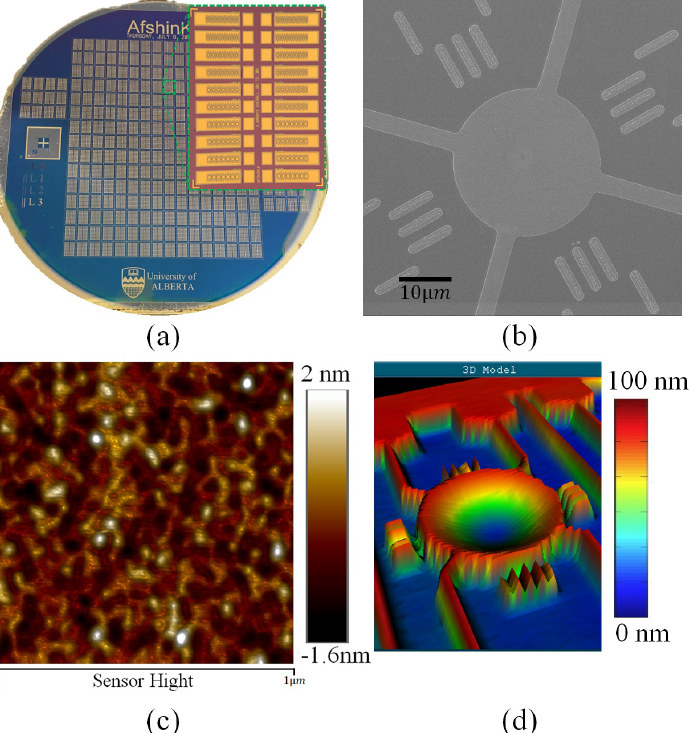
Figure 9. Fabricated CMOF-MEMS deformable mirrors. ( a ) A full wafer view of the fabricated dies; ( b ) helium ion microscopy image of a CMOF-MEMS cell with a 20 µ m radius; ( c ) AFM surface profile of a CMOF-MEMS mirror at the centre of the mirror; ( d ) 3D reconstructed image taken by the ZYGO optical profilometer of a CMOF cell with a 30 µ m radius and a 100 nm central